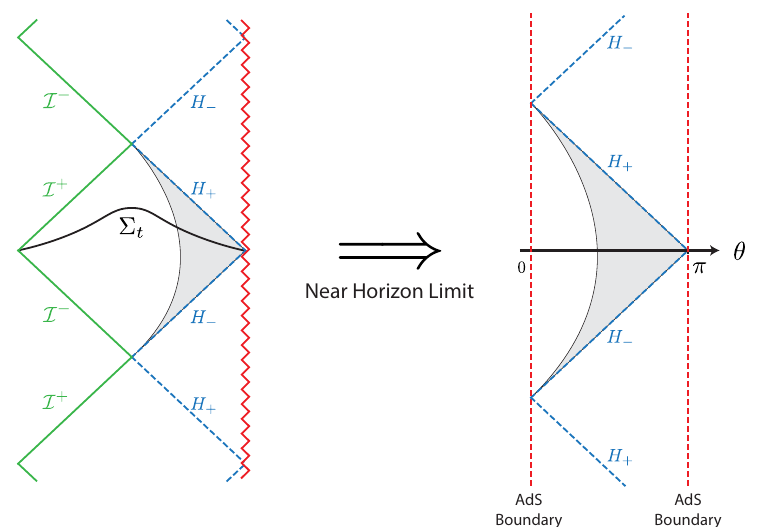
Figure 4 . On the left we see the maximally extended Penrose diagram of the extremal Reissner- Nordstrom black hole. Taking the near horizon limit we obtain the AdS 2 × S d − 2 space-time on the right, see [27]. The gray shaded region corresponds to the section of the black hole that is well approximated by AdS 2 × S d − 2